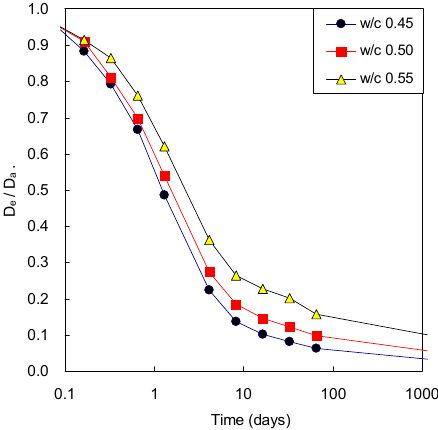
Figure 8. Comparison of effective CO 2 diffusivity of concrete (D e ) and apparent CO 2 diffusivity (D a ) after carbonation.